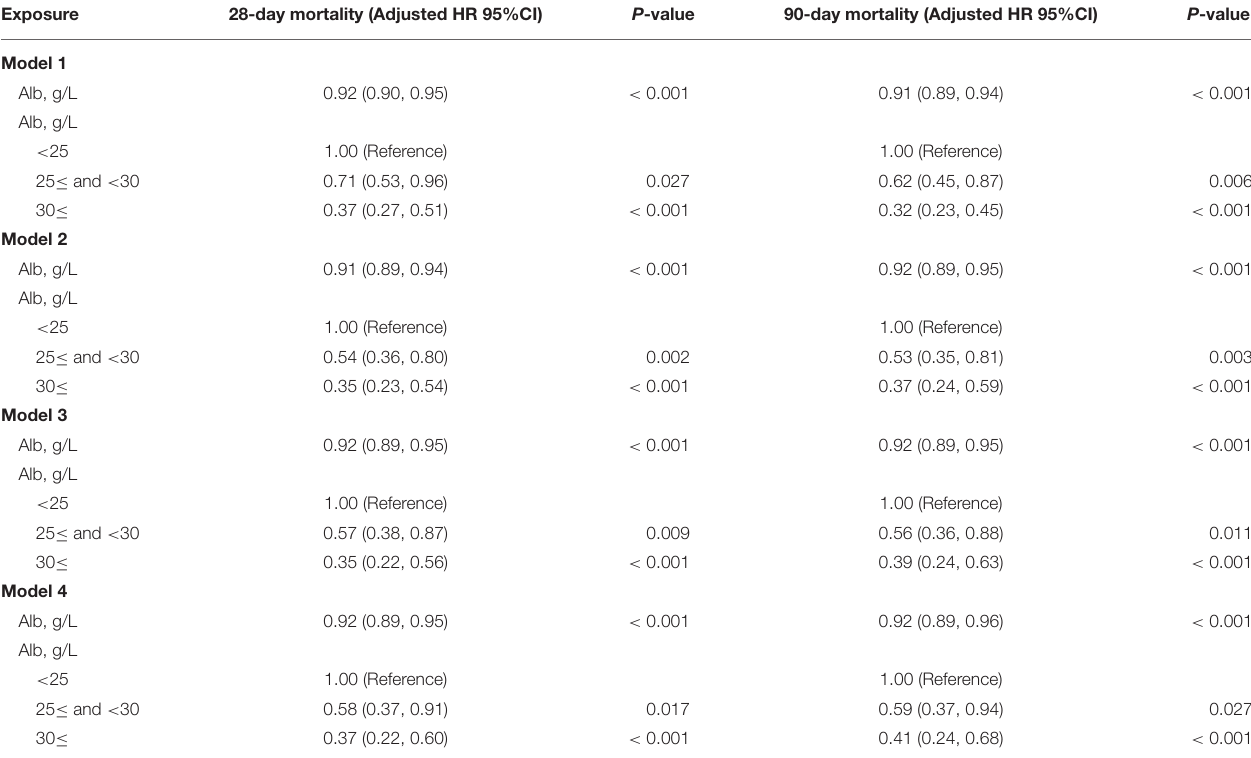
TABLE 2 | Multivariate logistic regression analysis for 28- and 90-day mortality.